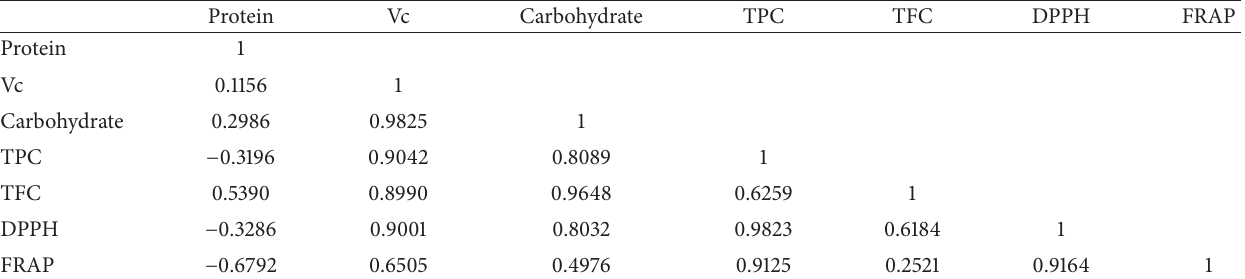
Table 4: Correlation matrix of bioactive components in Hawk tea infusions and their antioxidant capacity. Protein Vc Carbohydrate TPC TFC DPPH FRAP